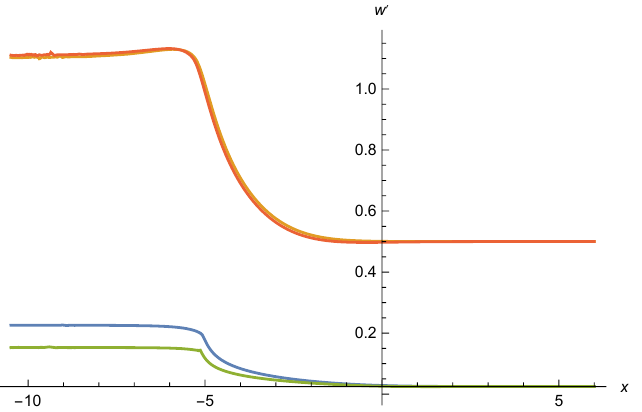
Figure 16. Nonminimal scalar coupling w (cid:48) ( ˜ ρ ) as function of x = ln ˜ ρ . Parameters and color coding are the same as for Figures 17 and 18. The value ξ ∞ = 2 w (cid:48) ( x → ∞ ) can be read